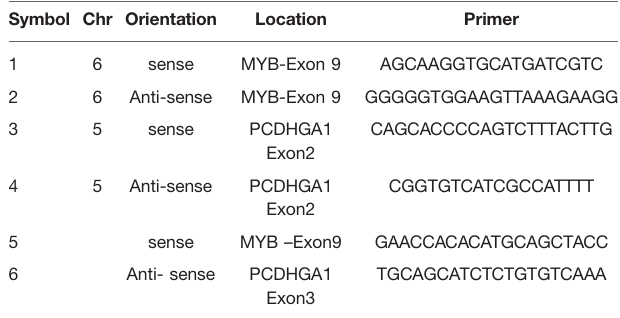
TABLE 2 | List of primers for RT-PCR reaction for MYB